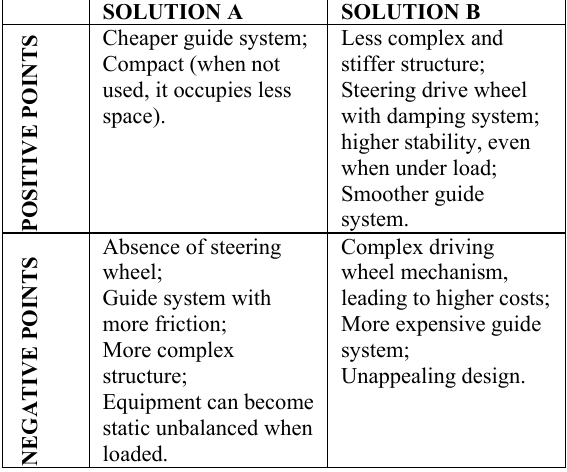
Table 1. Comparative evaluation of both